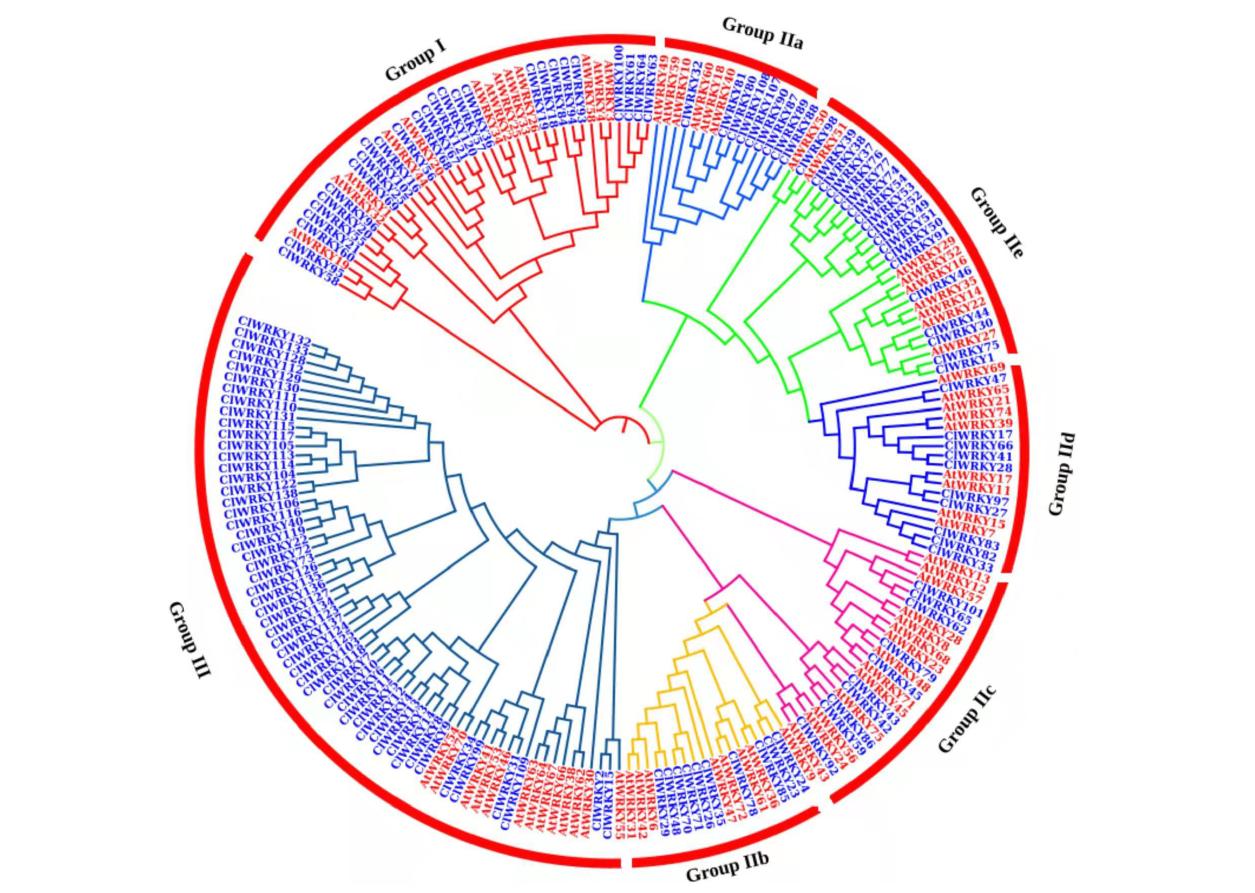
FIGURE 2 | A phylogenetic tree of 138 ClWRKY proteins of Chrysanthemum lavandulifolium (blue) and 74 AtWRKY proteins of Arabidopsis thaliana (red) on the basis of amino acid sequences. The tree was constructed in MEGA X. The domains were clustered into three groups, namely, group I, group II, and group III. The group II was divided into five subgroups